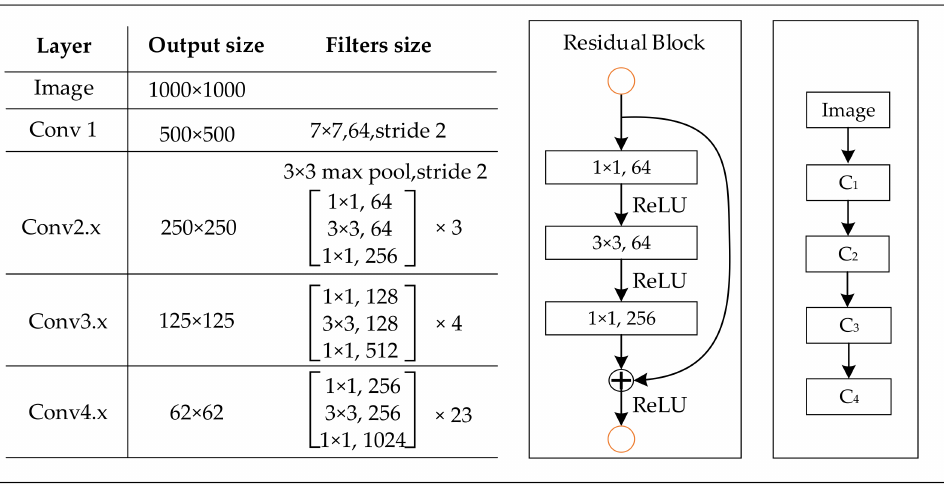
Figure 4. Structure of the backbone